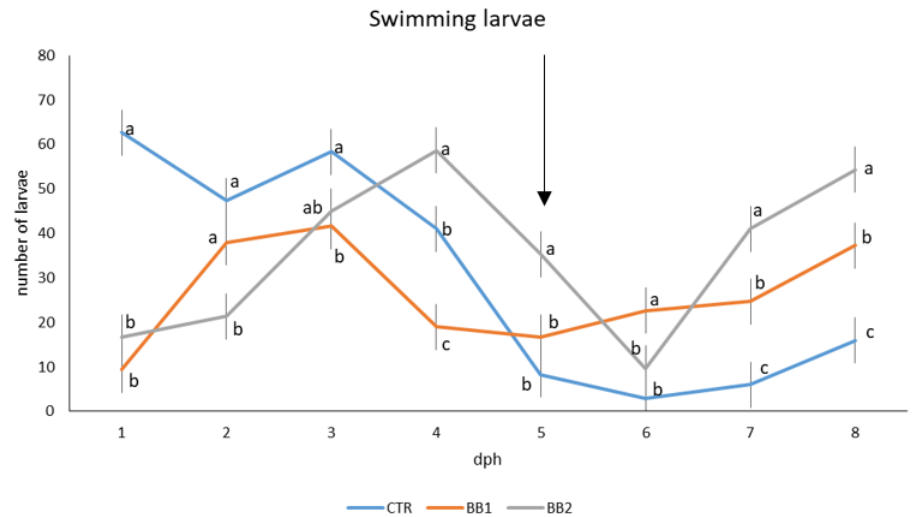
Figure 1. Number of larvae of A. baerii swimming in the water column for each treatment, from T0 to T2. Blue line, CTR, orange line, BB1, grey line, and BB2. Error bars indicate the standard error of the mean for each treatment/stage of development; a,b,c Means with different superscripts differ significantly between treatments ( p < 0.05); arrow indicating schooling phase (T1).